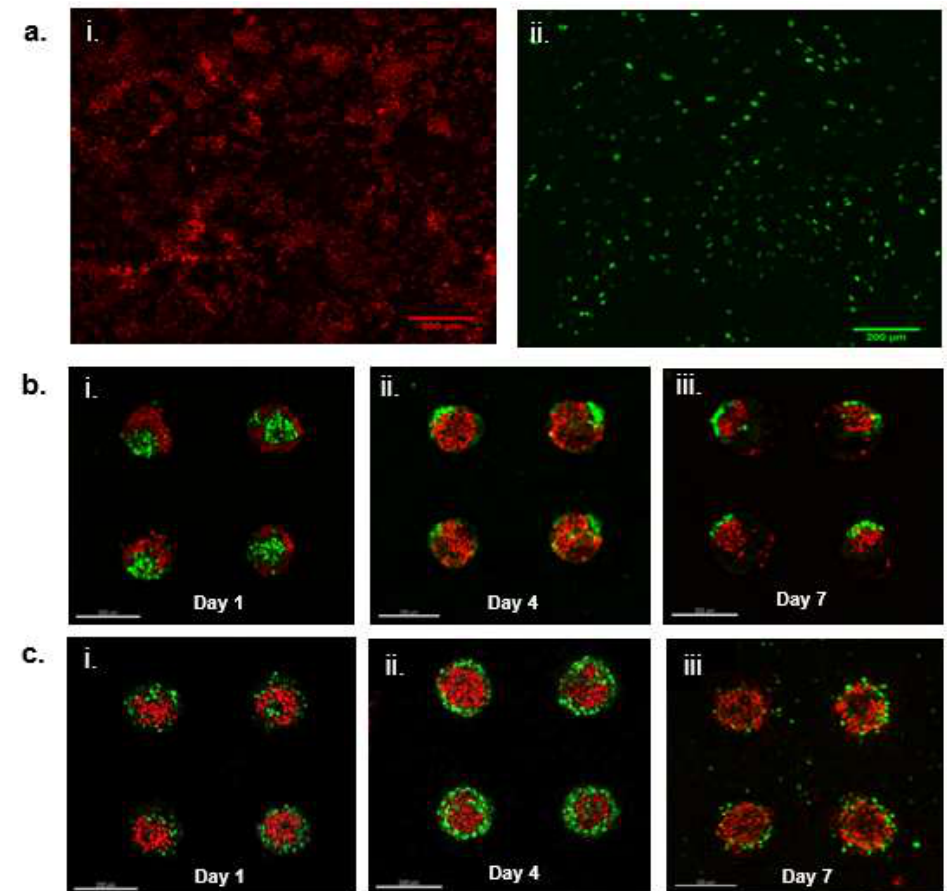
Figure 3. Distributions of green fluorescent protein (GFP)-expressing DP cells and red fluorescent protein (RFP)-expressing HaCaT keratinocytes in 3D cultures ( a ). Images showing fluorescence signals retained in (i) RFP-expressing HaCaT and (ii) GFP-expressing DP ( b ). Confocal images showing (i) 3D PEGDA microwells containing GFP-expressing DP surrounded by RFP-expressing HaCaT after day 1 of co-incubation. (ii) Shrinking of GFP-expressing DP aggregate on day 4 of co- incubation. (iii) Exfoliation of RFP-expressing HaCaT from co-cultured aggregates on day 7 of incubation of co-incubation ( c ). Confocal images showing (i) 3D GelMA microwells containing GFP-expressing DP surrounding RFP-expressing HaCaT after day 1 of co-incubation. (ii) GFP-expressing DP cells surrounding RFP-expressing HaCaT on day 4 of co-incubation. (iii) RFP-expressing HaCaT keratinocytes retained inside the microwells on day 7 of co-incubation. All scale bars represent 200 μm.